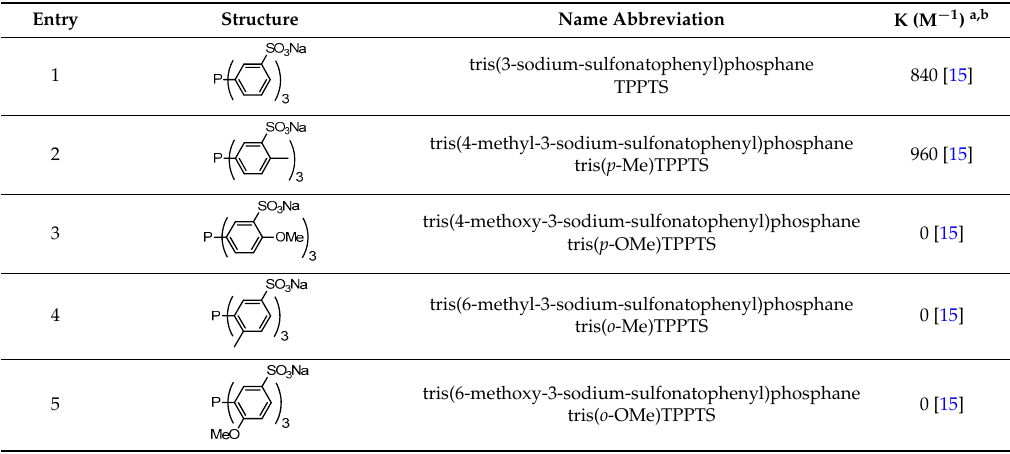
Table 1. Structure, abbreviation of the water-soluble phosphanes used, and value of the association constant (K) for the inclusion complexes between the RAME- β -CD and the phosphane.